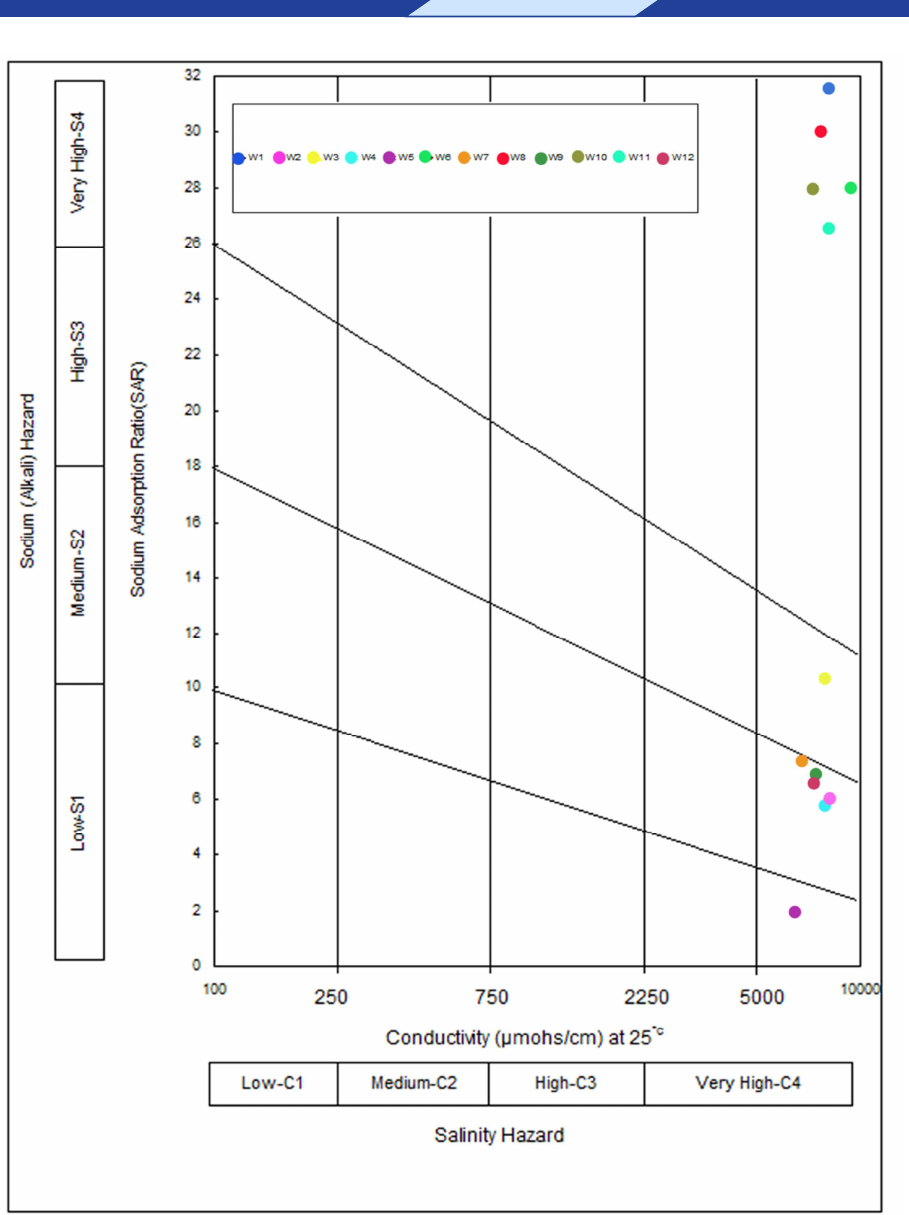
Figure 2. Wilcox diagram of Birjand, Iran f1ood